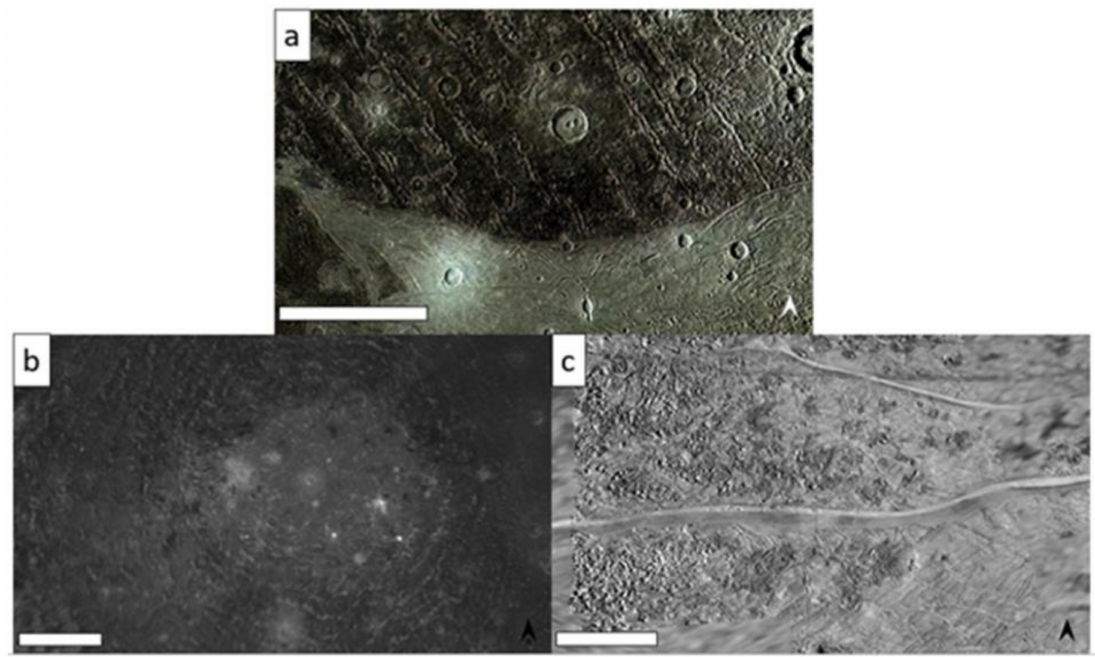
Figure 7. Examples of CO 2 features across some of the Galilean satellites. ( a ) Dark terrain and furrows on Ganymede (scale bar 250 km); ( b ) Callisto with brighter, fresher CO 2 deposits (scale bar 250 km); ( c ) Lineae features on Europa (scale bare 75